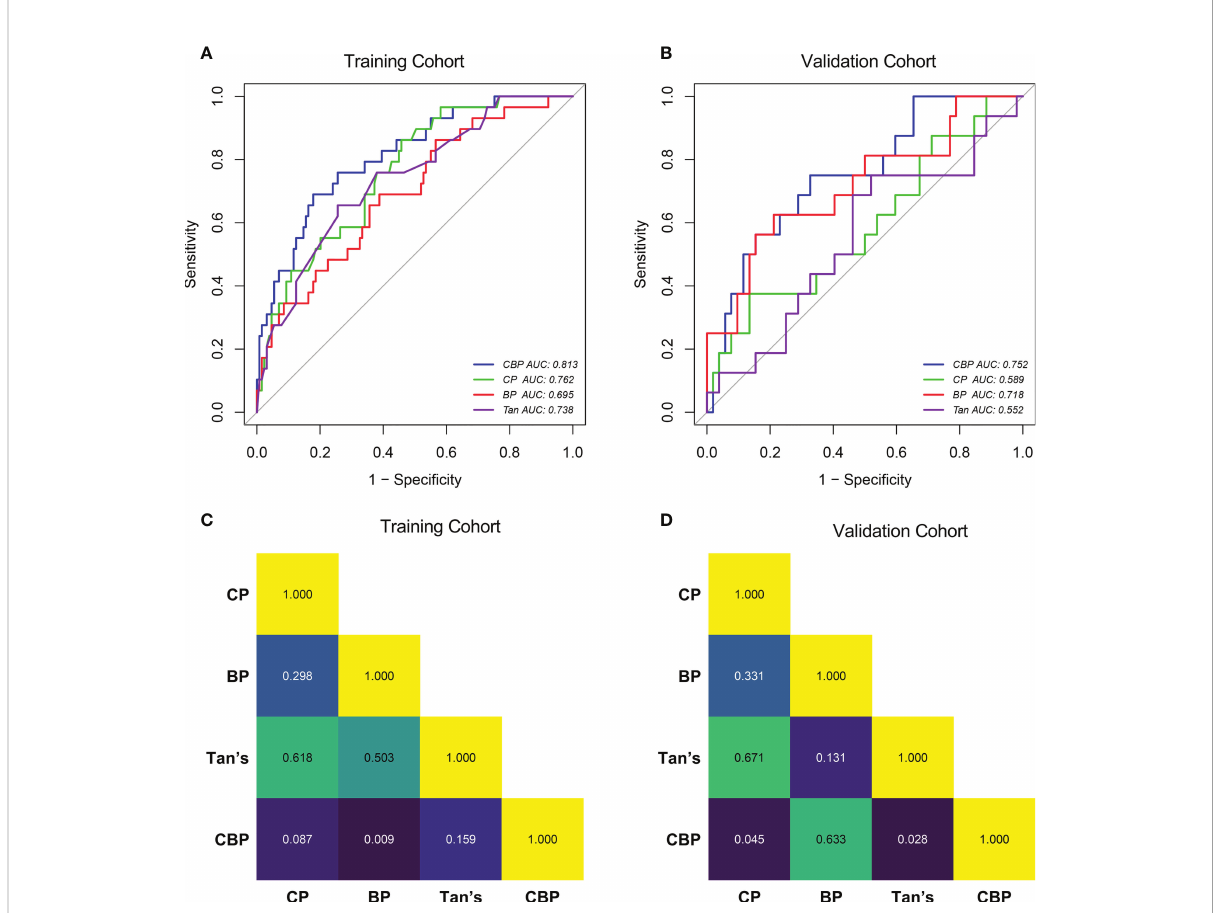
FIGURE 3 ROC curves of the CP, BP, CBP and Tan in Training cohort (A) and Validation cohort (B) . Delong test P -value of Training cohort (C) and Validation cohort (D) . CP clinical parameters model, BP blood parameters model, CBP clinical-blood parameters